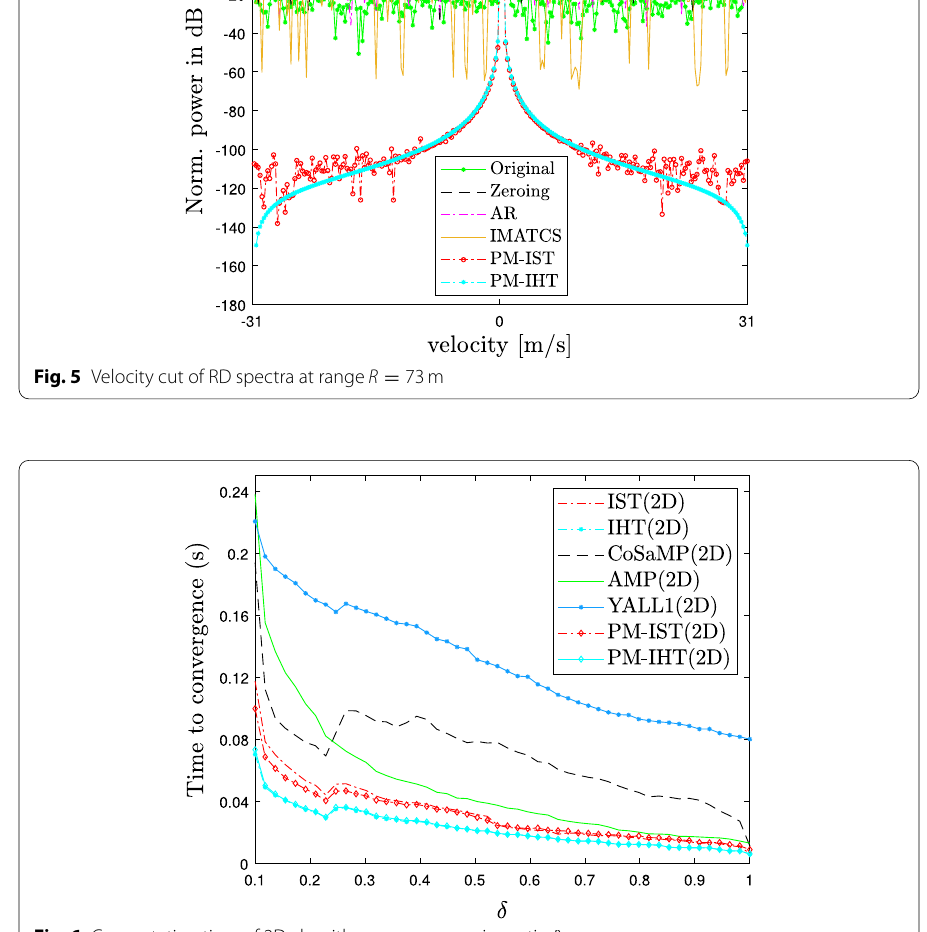
Fig. 6 Computation time of 2D algorithms vs. compression ratio